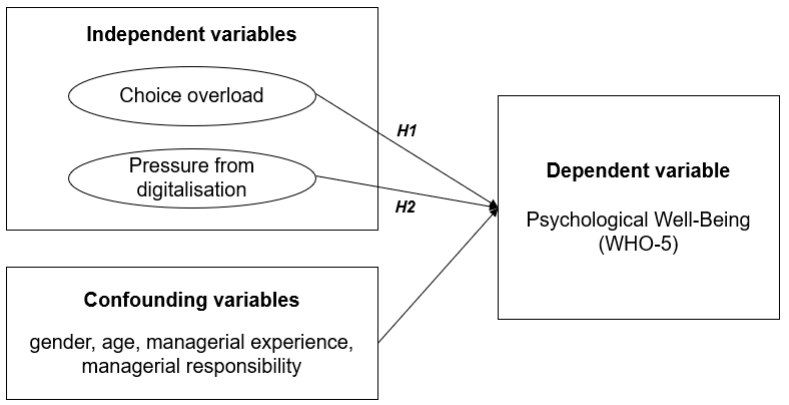
Figure 2. Research model for statistical analysis.